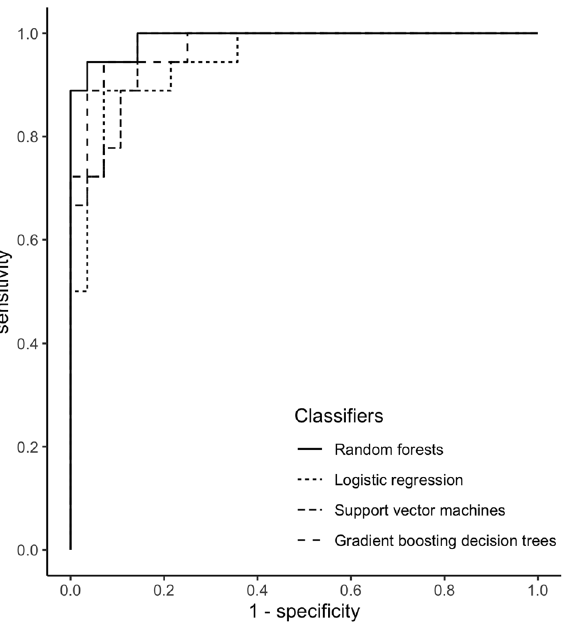
Figure 2. Receiver operating characteristic curves in the test cohort (n = 46) for predicting unilateral subtype of primary aldosteronism in each developed classifier.